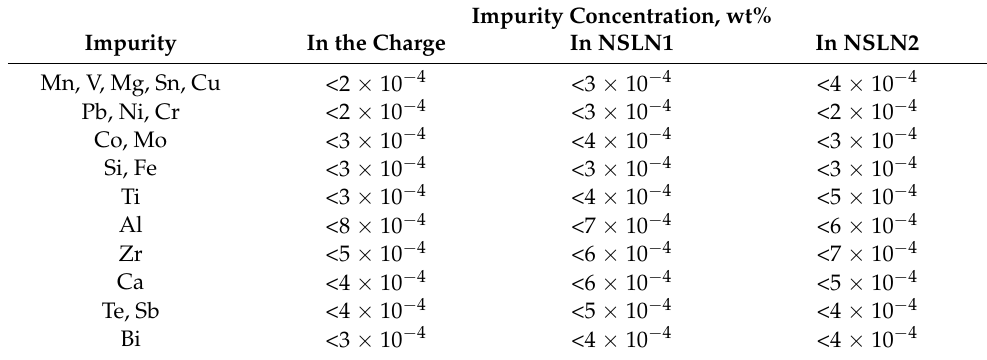
Table 1. Impurity composition of the initial charge and two studied NSLN crystals.